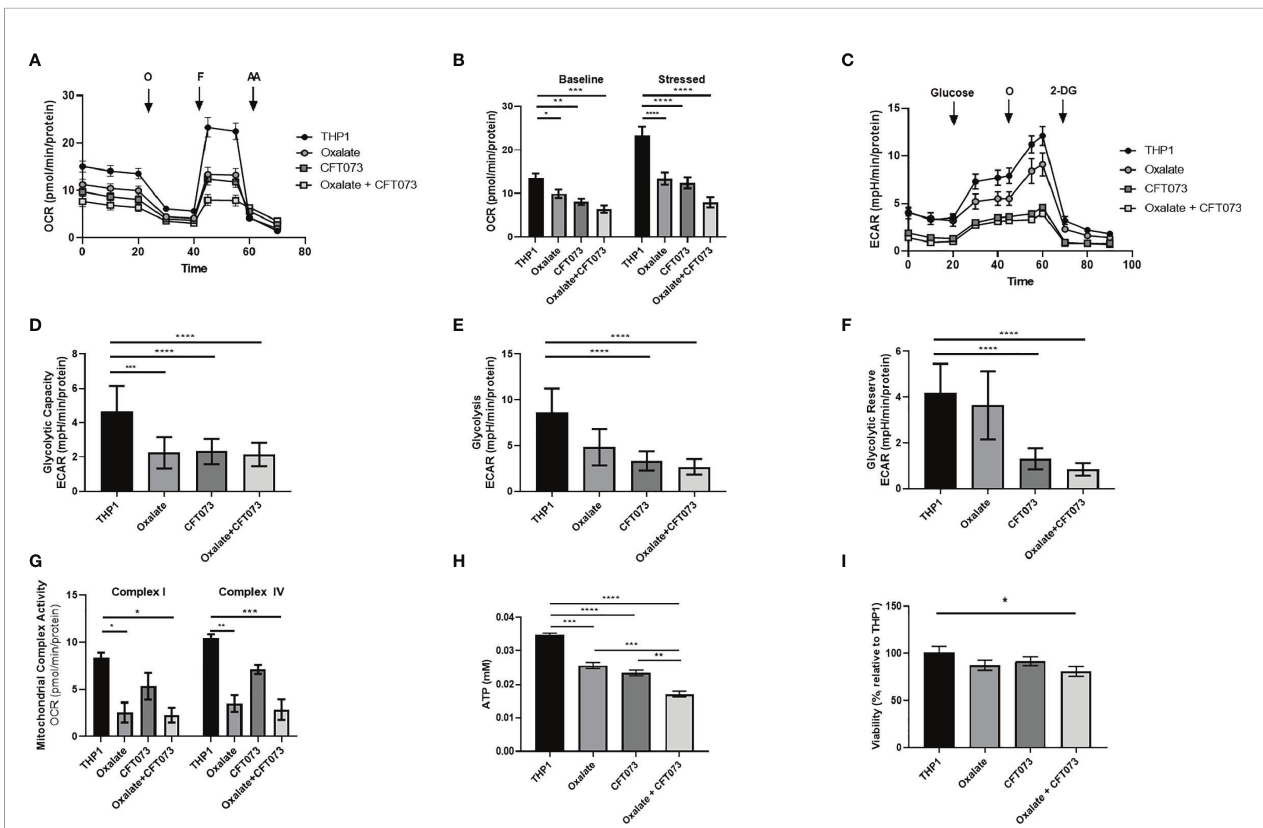
FIGURE 1 | Oxalate reduces cellular bioenergetics and ATP production in THP-1 macrophages. THP-1 macrophages were plated in Seahorse plates prior to being exposed to oxalate with or without CFT073 (MOI 1:2) as described in the Materials and Methods section. The Seahorse XF Analyzer and (A) The “ Mitochondrial Stress Test ” was used to assess macrophage oxygen consumption rate over time. (B) Baseline and stressed OCR parameters were calculated from the “ Mitochondrial Stress Test ” . (C) The “ Glycolysis Stress Test ” was used to assess macrophage extracellular acidi fi cation rate over time. (D) Glycolytic capacity, (E) glycolysis, and (F) glycolytic reserve parameters were derived from the “ Glycolysis Stress Test ” . (G) Mitochondrial Complex I and IV activities were assessed after permeabilizing the cells and adding substrates as described in the methods. (H) Intracellular ATP levels in macrophages were determined as described in detail in the Materials and Methods section. (I) Viability of THP-1 macrophages using the CCK8 assay. All experiments were performed at least three times with n=5-8 replicates. Data are expressed as means ± SEM. *p < 0.05, **p < 0.01, ***p < 0.001, ****p < 0.0001 is signi fi cant compared to control THP-1 macrophages or CFT073